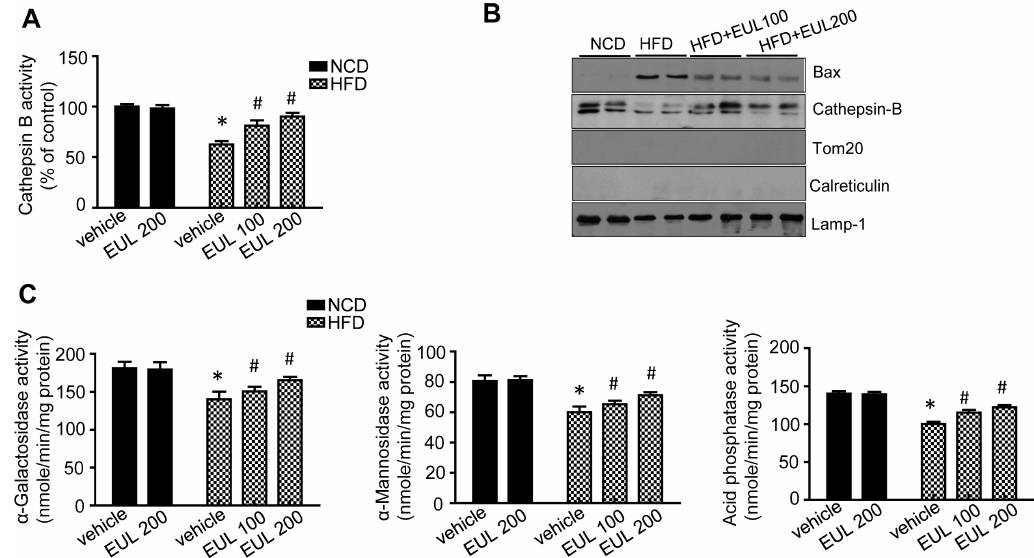
Figure 6. EUL regulates HFD-induced lysosomal Bax localization and lysosomal enzyme activation. ( A ) Cathepsin B activity in liver lysates. ( B ) Western blotting with antibodies against Bax, cathepsin B, LAMP-1, and tubulin. ( C ) Liver levels of α -galactosidase, α -mannosidase, and acid phosphatase. Values are means ± SDs. ( n = 6, * p < 0.05 versus NCD group, # p < 0.05 versus HFD group). NCD, normal chow diet; HFD, high-fat diet; and EUL, Eucommia ulmoides leaf extract.